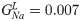
Membrane potential time traces from model inhibitory neurons.Panel (a) shows time trace from the model replicating interneurons from NTG mice using GNaL=0.007 mS/cm2 and (b) replicates APdE9 mice using GNaL=0.028 mS/cm2. Istim = 80 pA was used in these simulations. All other parameters are as given in the text.